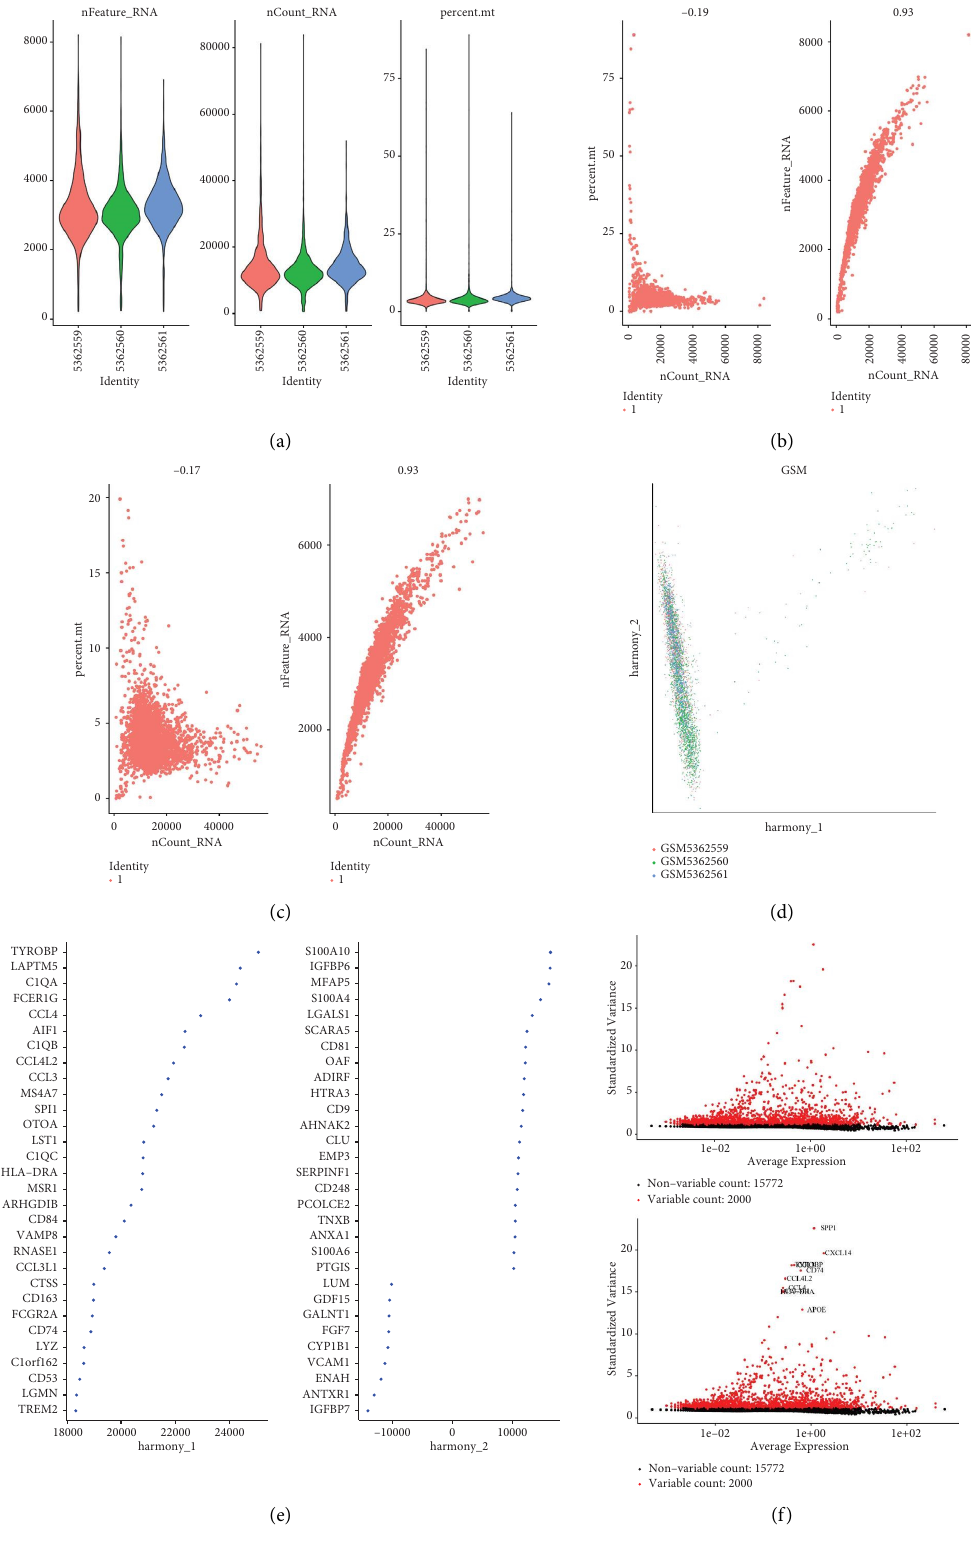
Figure 3: (a) Gene data detected in each cell, total number of molecules detected in the cell, and fraction of the mitochondrial genome in the cell. (b) Correlation between basic data before fltering. (c) Correlation between fltered base data. (d) After PCA, multiple PC groups with large diferences can be used as anchor points. (e, f) Te screening of the hypervariable